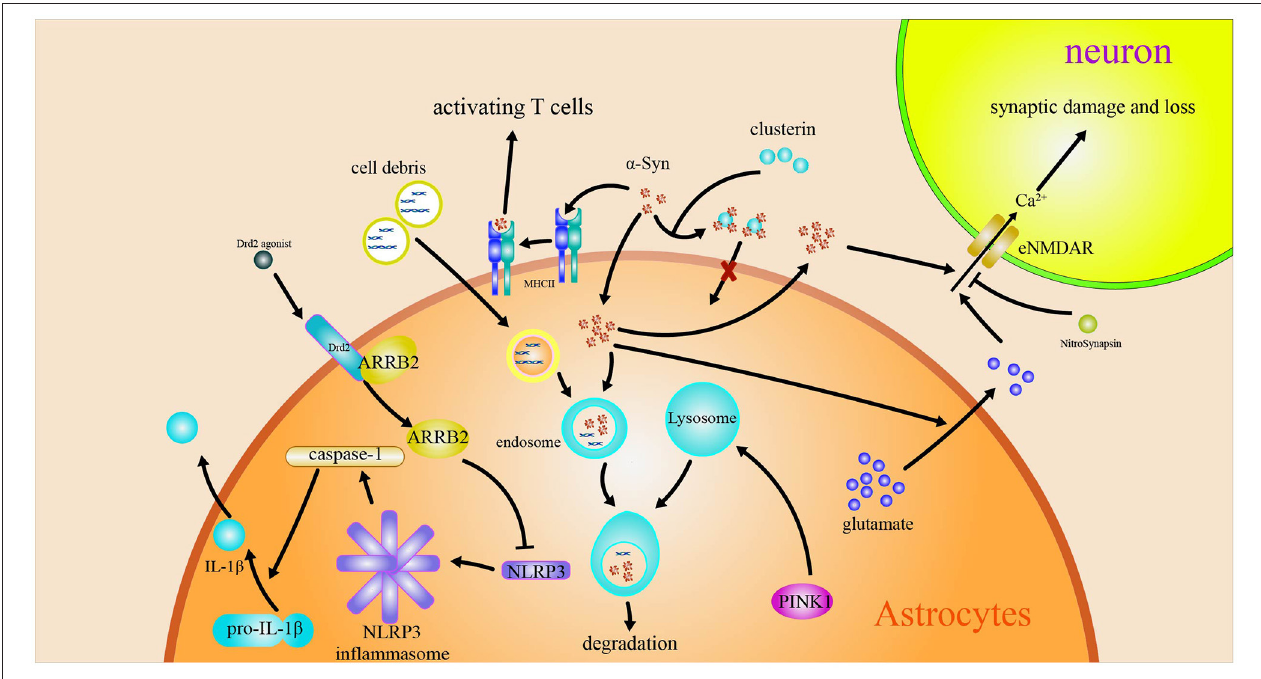
FIGURE 2 | Astrocytes in Parkinson’s disease. The engulfed α -syn has a variety of effects on astrocytes. The α -syn induces MHC-II expression in astrocytes and activates T cells. The α -syn induces the release Ca2 + -dependent glutamate and activates eNMDARs to accelerate the injury and loss of synapsis. Drd2 inhibits the activation of NLRP3 by regulating β